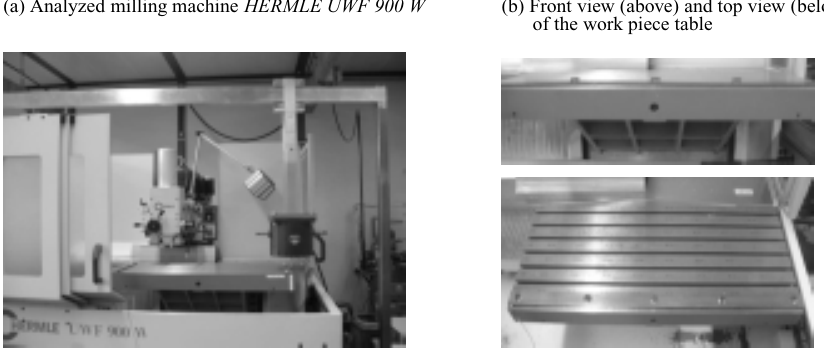
Fig. 5. Analyzed milling machine and work piece table with attached friction beam.